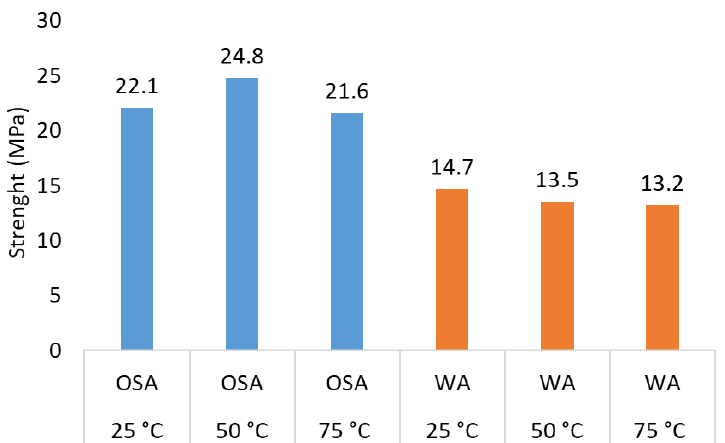
Figure 12. Compressive strength values at different temperatures (10 bar, 100% CO 2 , 150 kgf/cm 2 ) (Average values obtained from min. 4 samples (std. deviation < 3%)).